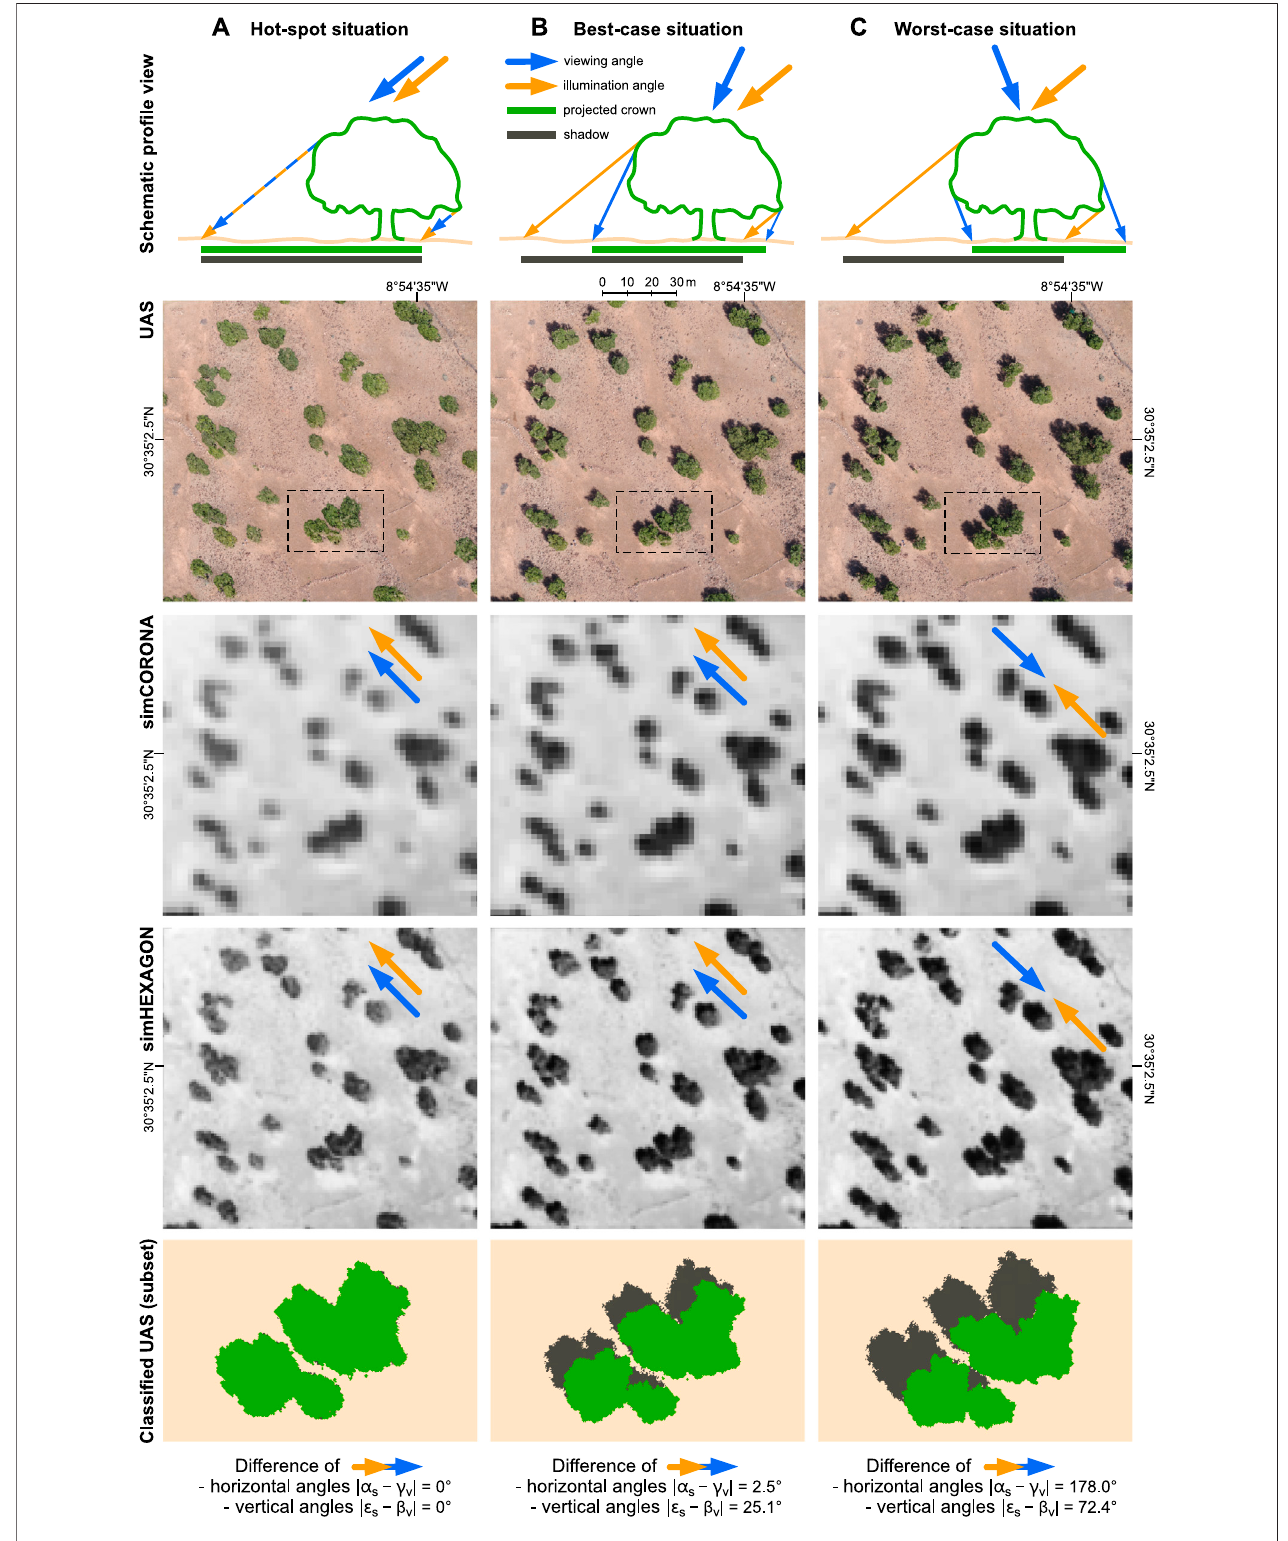
FIGURE 5 | Effect of varying viewing directions (blue arrows) relative to sun illumination (orange arrows) on the appearance of individual trees at test site IRG2d, showing theoretical hot-spot situation (A) , actual best-case (B) and actual worst-case situation (C) in UAS imagery simulated from 3D point clouds (top row), simulated CORONA imagery (2.2 m resolution, second row) and simulated HEXAGON imagery (1.0 m resolution, third row). Subsets (bottom row) show exemplary tree spots classi fi ed into crown and shadow area. Crown/shadow percentages at test site vary from 100%/0% (A) over 70%/30% (B) to 59%/41% (C) . For parameter abbreviations, see Figure 3